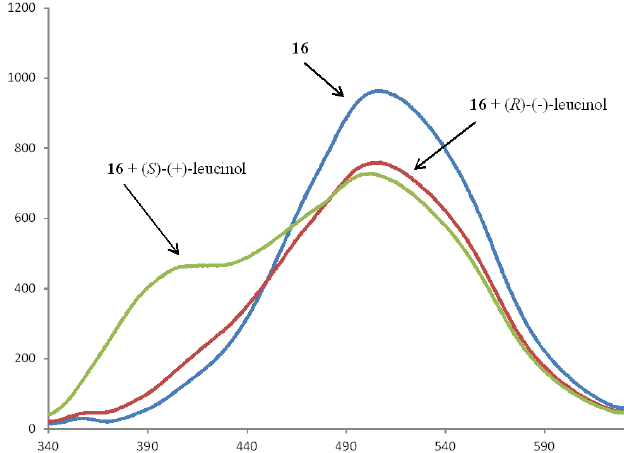
Figure 5. Fluorescence spectra of compound 15 in the presence of ( R )- and ( S )-enantiomers of 2-amino-1-propanol (1000 equiv.); ( a ) general view; ( b ) schematic representation of the changes in emission.